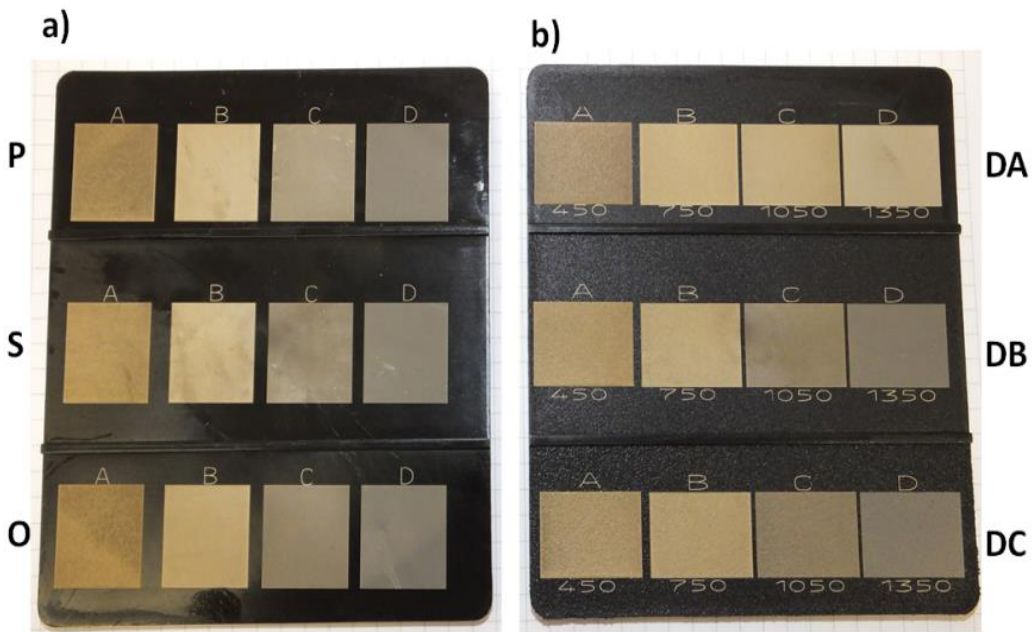
Figure 3. A graphic representation of the ways to modify the surfaces of the plates with the references to the adopted laser parameter (a plate on the right). ( a ) The surfaces: The polished one (P), the ground one (S), and the honed one (O). ( b ) The surfaces: The EDM (DA) one, the EDM (DB) one, and the EDM (DC) one.